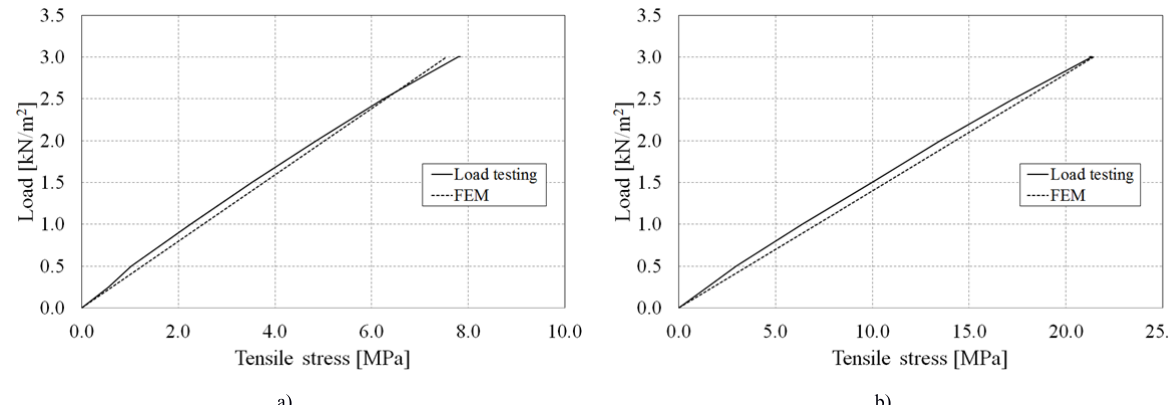
Fig. 12 Comparison of the measured and FEM tensile stress a) σ g.A+ in glass at section A-A and b) σ s.A+ in steel at section A-A.